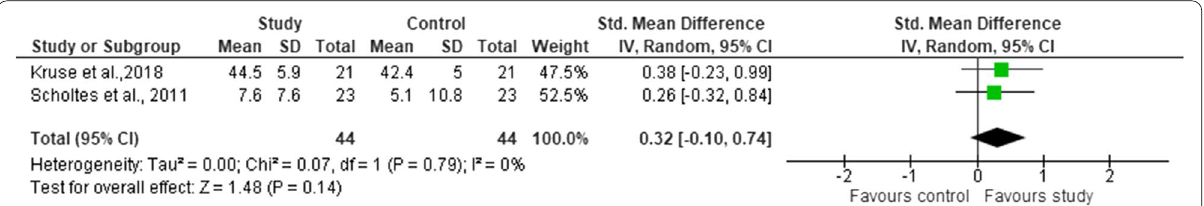
Fig. 3 Forest plot of comparison between study and control groups regarding plantar flexion angle — post-intervention